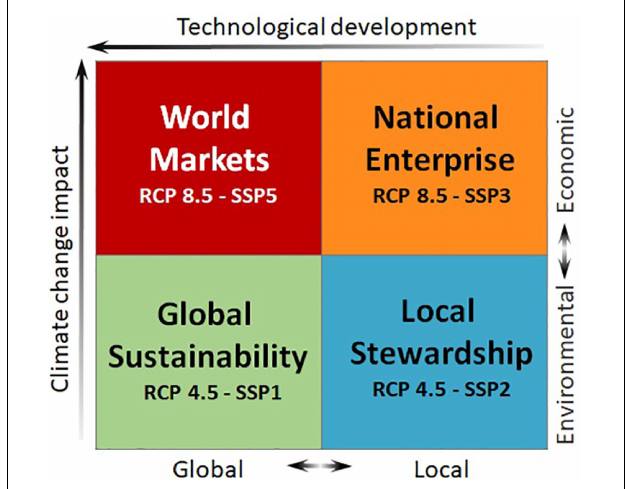
FIGURE 3 | Conceptualization of the four CERES scenarios in terms of impact and adaptation. Direction of the arrows indicates an increasing development/impact. Double arrows indicate diverging socio-political